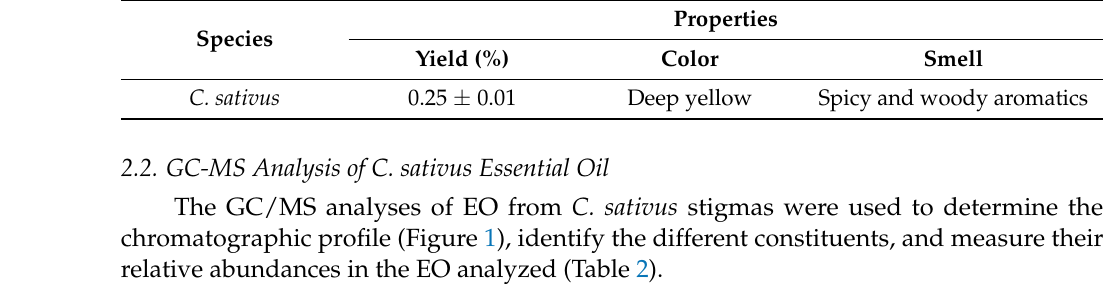
Table 1. The yield of the essential oil of C. sativus . Properties Species Yield (%) Color Smell 0.25 ± 0.01 Deep yellow